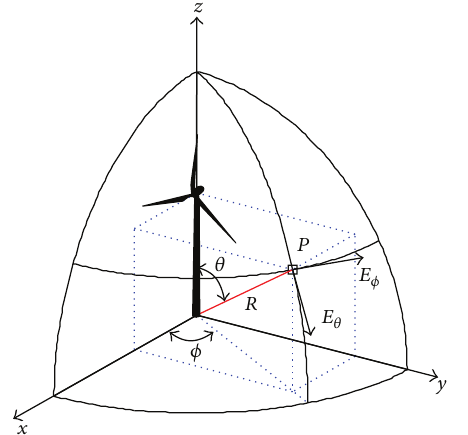
Figure 1: Spherical coordinate system used in the RCS calculations.